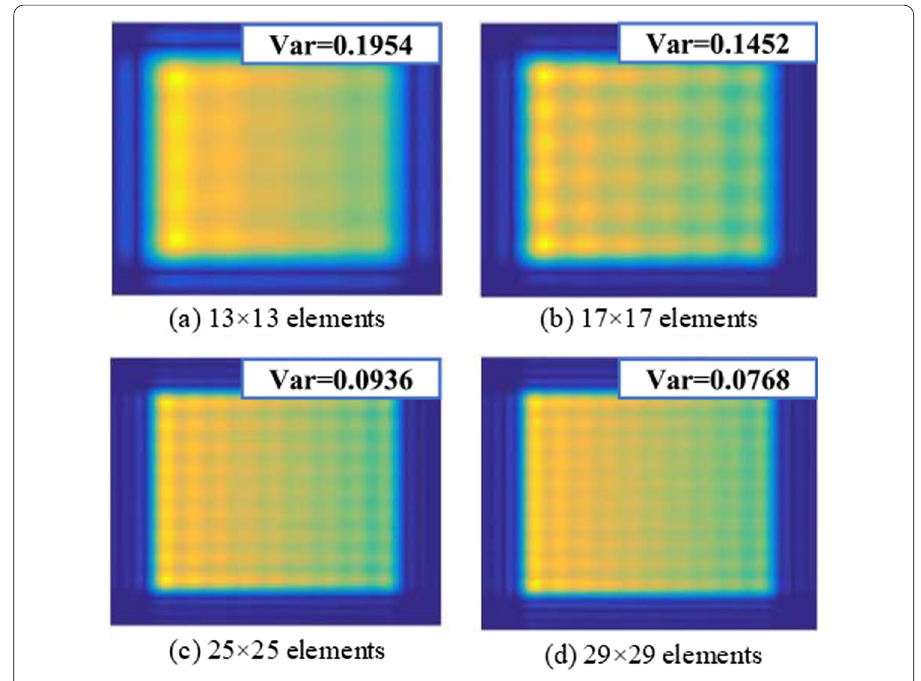
Fig. 7 Beam patterns of different elements